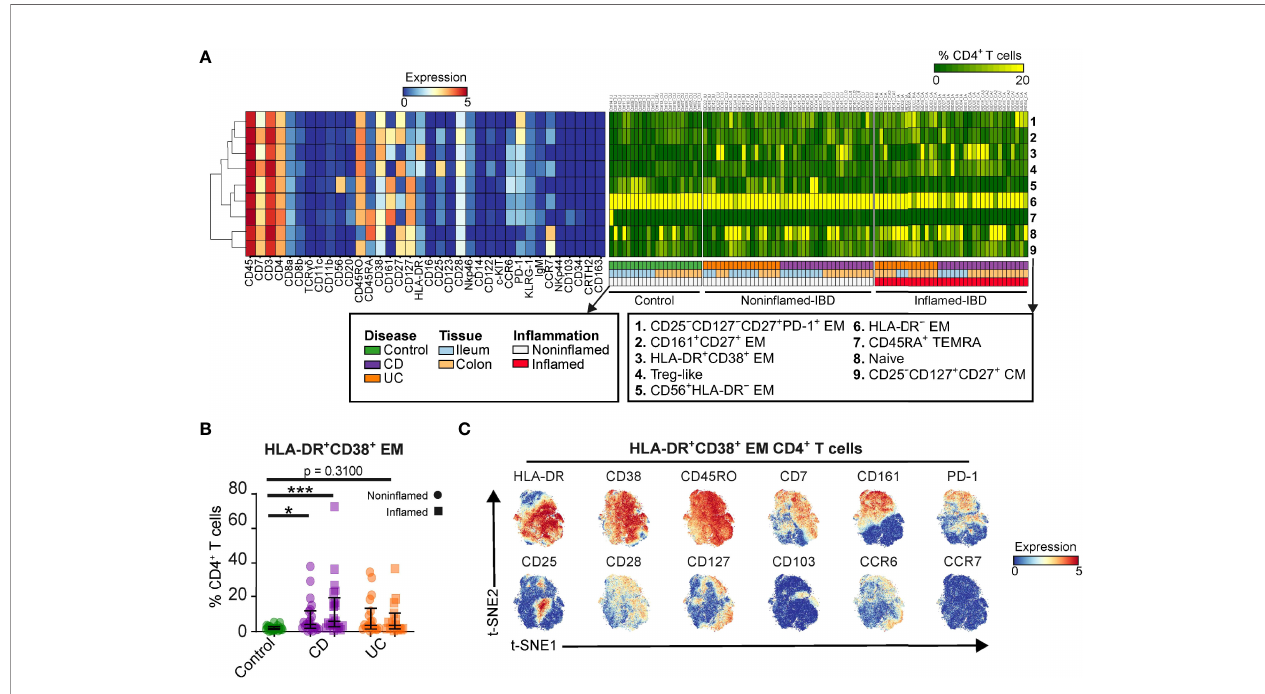
FIGURE 2 | The CD4 + T cell lineage dissected into distinct cell subsets. (A) Heatmaps showing characteristics of 9 CD4 + T cell subsets (marker expressions; rainbow scale), cell subset composition of intestinal samples (cell percentages; green-to-yellow scale), clinical metadata and hierarchical clustering of marker expression pro fi les. (B) Graph showing cell frequency of HLA-DR + CD38 + EM CD4 + T cell cluster for 99 intestinal biopsies of the primary cohort. Bars indicate the median with interquartile range. *p ≤ 0.05, ***p ≤ 0.001, Kruskal Wallis test for multiple groups. (C) t-SNE embedding showing 61,930 cells colored for the expression values of the indicated